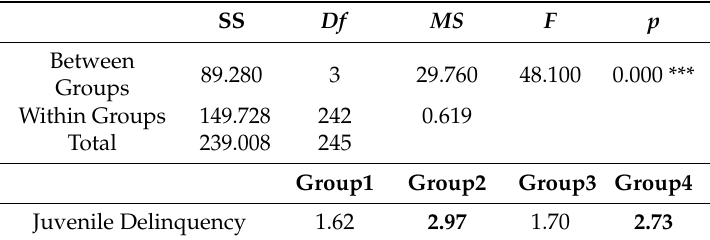
Table 5. Result of ANOVA, mean scores, and scale reliability: Differences in juvenile delinquency in esports between four groups based on the forms of families.